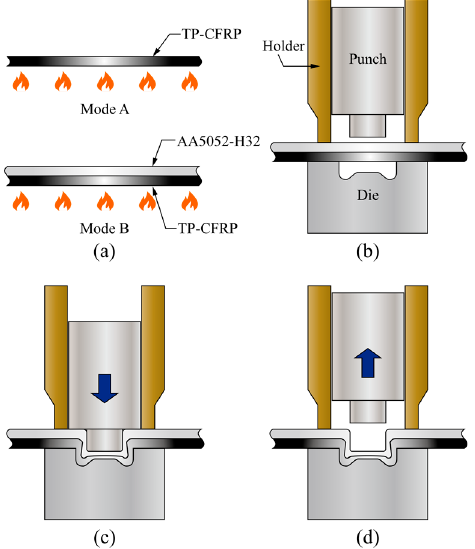
Figure 2. Preheated (heat-assisted) clinching process for AA5052 / TP-CFRP dissimilar clinch joints: ( a ) Preheating, ( b ) clamping, ( c ) punching, ( d ) retracting.